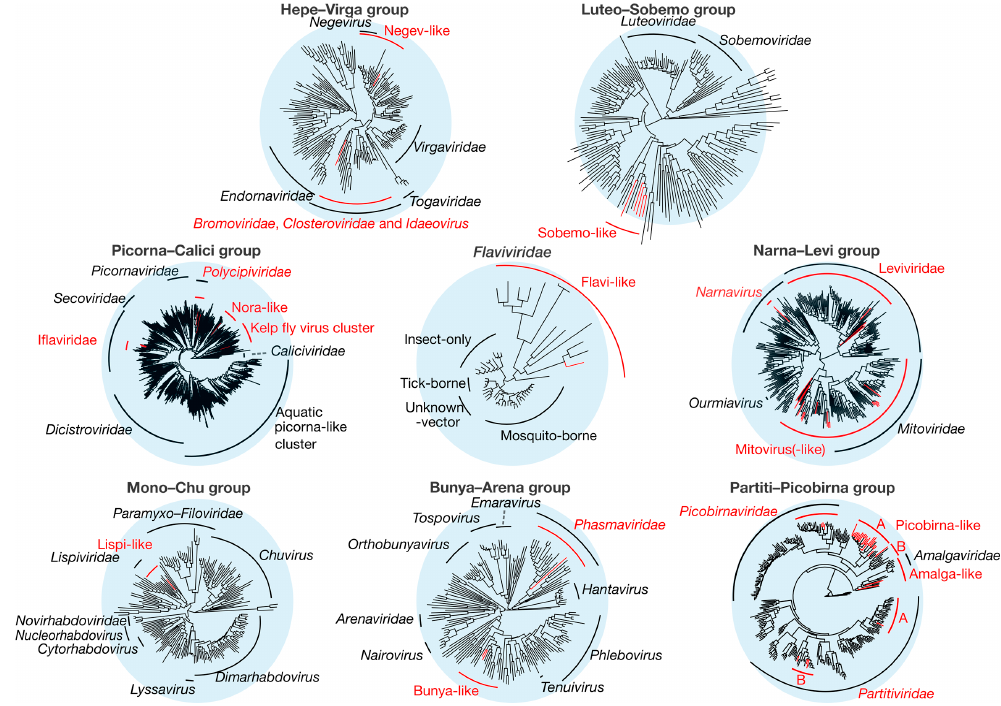
Figure 2. Overall phylogenetic trees representing each of the nine groups of RNA viruses (Table 2). Phylogenies were inferred using the gene encoding the RdRp, with the virus taxa (usually genera) identified in this study shown in red. Taxonomic groups of interest are labeled on the trees for reference. The sequence alignments used to infer the individual phylogenies are described in Supplementary Table S3. All trees are unrooted with branch length scaled to the number of amino acid substitutions per site.